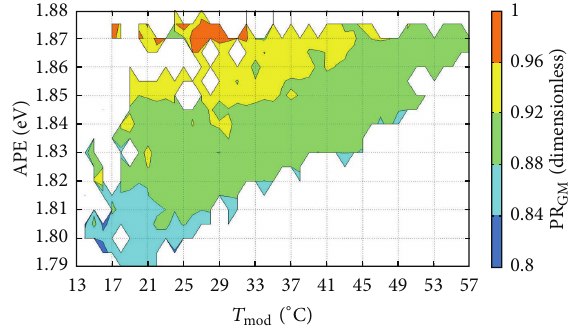
Figure 7: Contour graph of PR GM of the tested a-Si:H PV module as a function of 𝑇 mod and APE for the winter period. Blank areas indicate no data points.